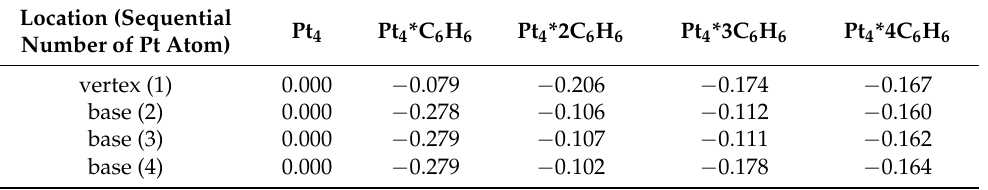
Table 8. Löwdin charges of Pt 4 and Pt-BZ adsorption complexes.